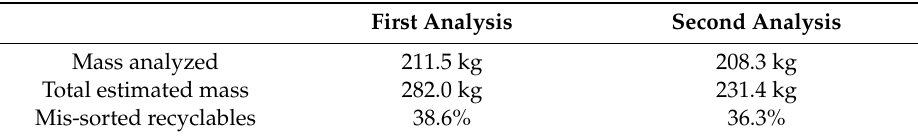
Table 1. Results of the pick analyses in the study area (160 single-room apartments). The first analysis took place before implementing the intervention, and the second took place after the intervention was implemented.